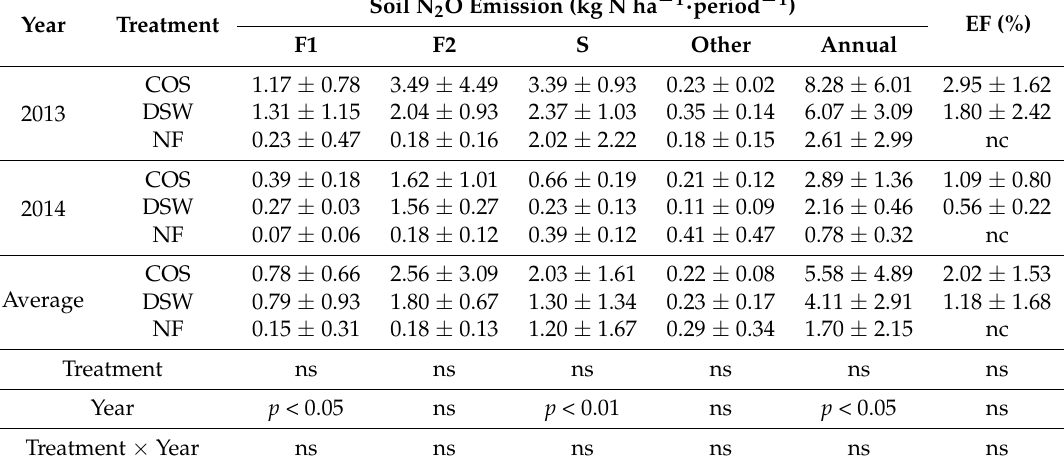
nc: not calculated, ns: not significant, F1: from 23 January to 22 March 2013 and from 20 January to 28 March 2014, F2: 22 March to 26 May 2013 and from 28 March to 30 May 2014, S: from 26 May to 22 August 2013 and 30 May to 25 August 2014, Other: from 22 August 2013 to 20 January 2014 and from 25 August to 22 December